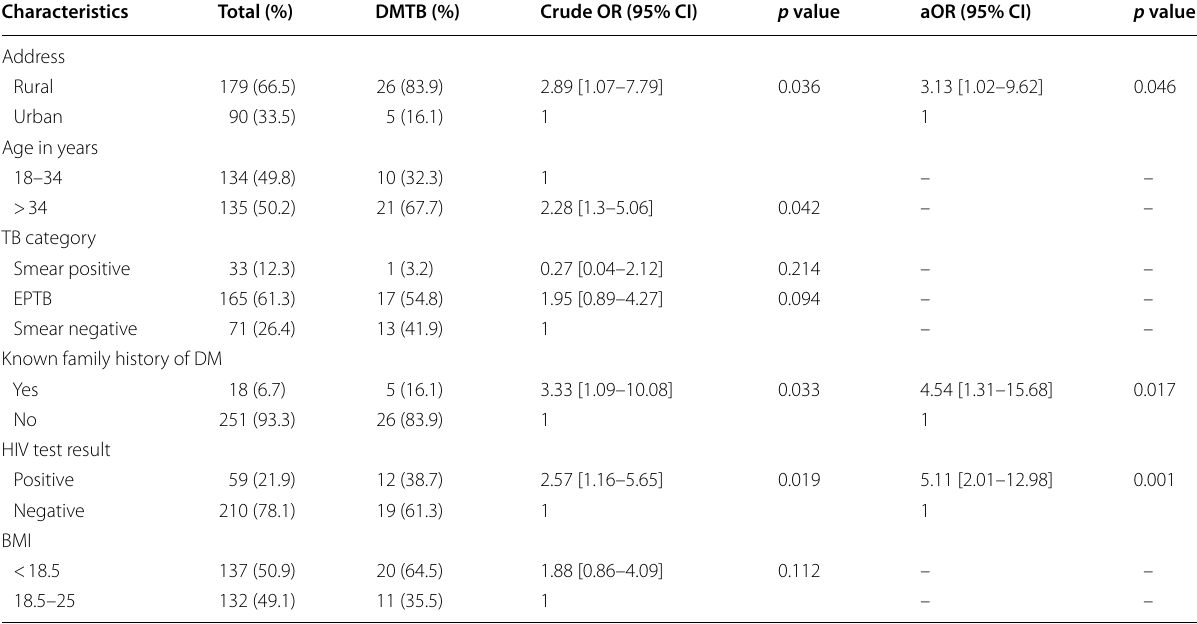
aOR adjusted odds ratio, CI confidence interval, OR odds ratio, BMI body mass index, EPTB extra-pulmonary TB, DM diabetes mellitus, TB tuberculosis, DMTB diabetic mellitus among tuberculosis